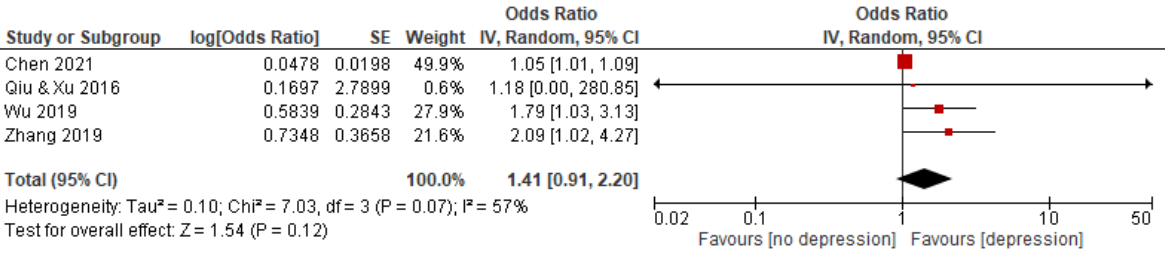
Figure 5. Forest plot of studies on association between YIDC and depression. Note: red square represents the result of each study; line represents the 95% CI of the results; diamond represents the pooled results.